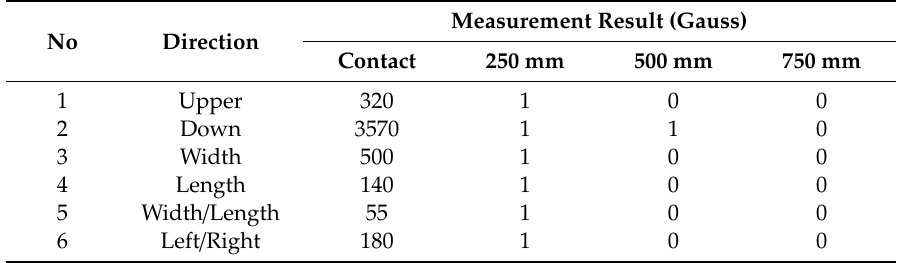
Table 7. Magnetic field measurement of elastic-rubber-coated magnet and magnetic liquid stop device.